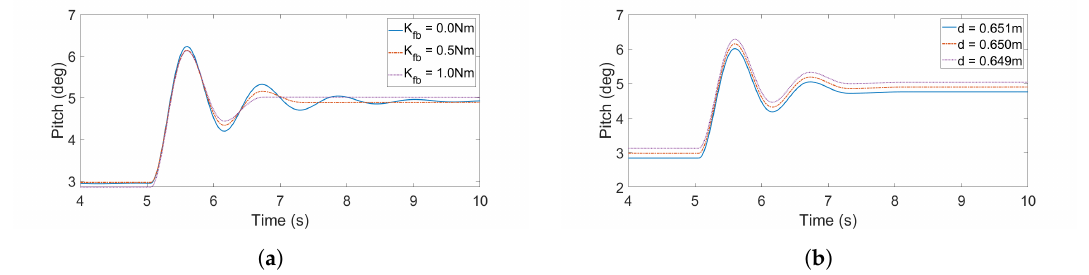
Figure 19. Importance of experimental inputs in decay test simulations. Results from quasi-linear numerical model, which computes moments linearly except from an approximated quadratic drag moment ( Cd = 2). ( a ) Influence of the moment due to friction in the bearings, M fb , on the calculated WEC motion during a decay test for the setup of only WEC. ( b ) Influence of 1 mm difference in water depth, d , on the calculated absorber position during a decay test for the setup of only